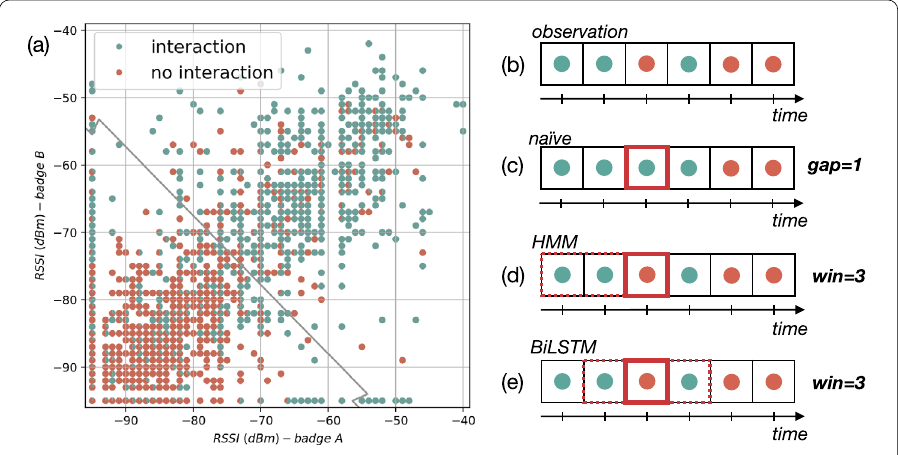
grey line; ( b – d ) Demonstration of reconstruction strategies of ( b ) an observed binary sequence of interactions using ( c ) a naïve method with gap = 1 threshold, ( d ) a HMM with window size win = 3 and ( e ) a BiLSTM with window size win =